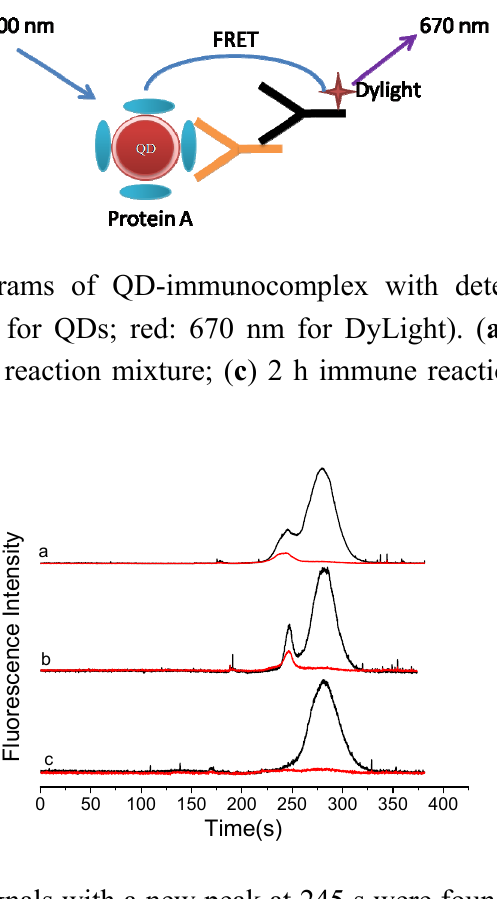
Scheme 1. Schematic illustration of the FRET between QDs and Dylight.